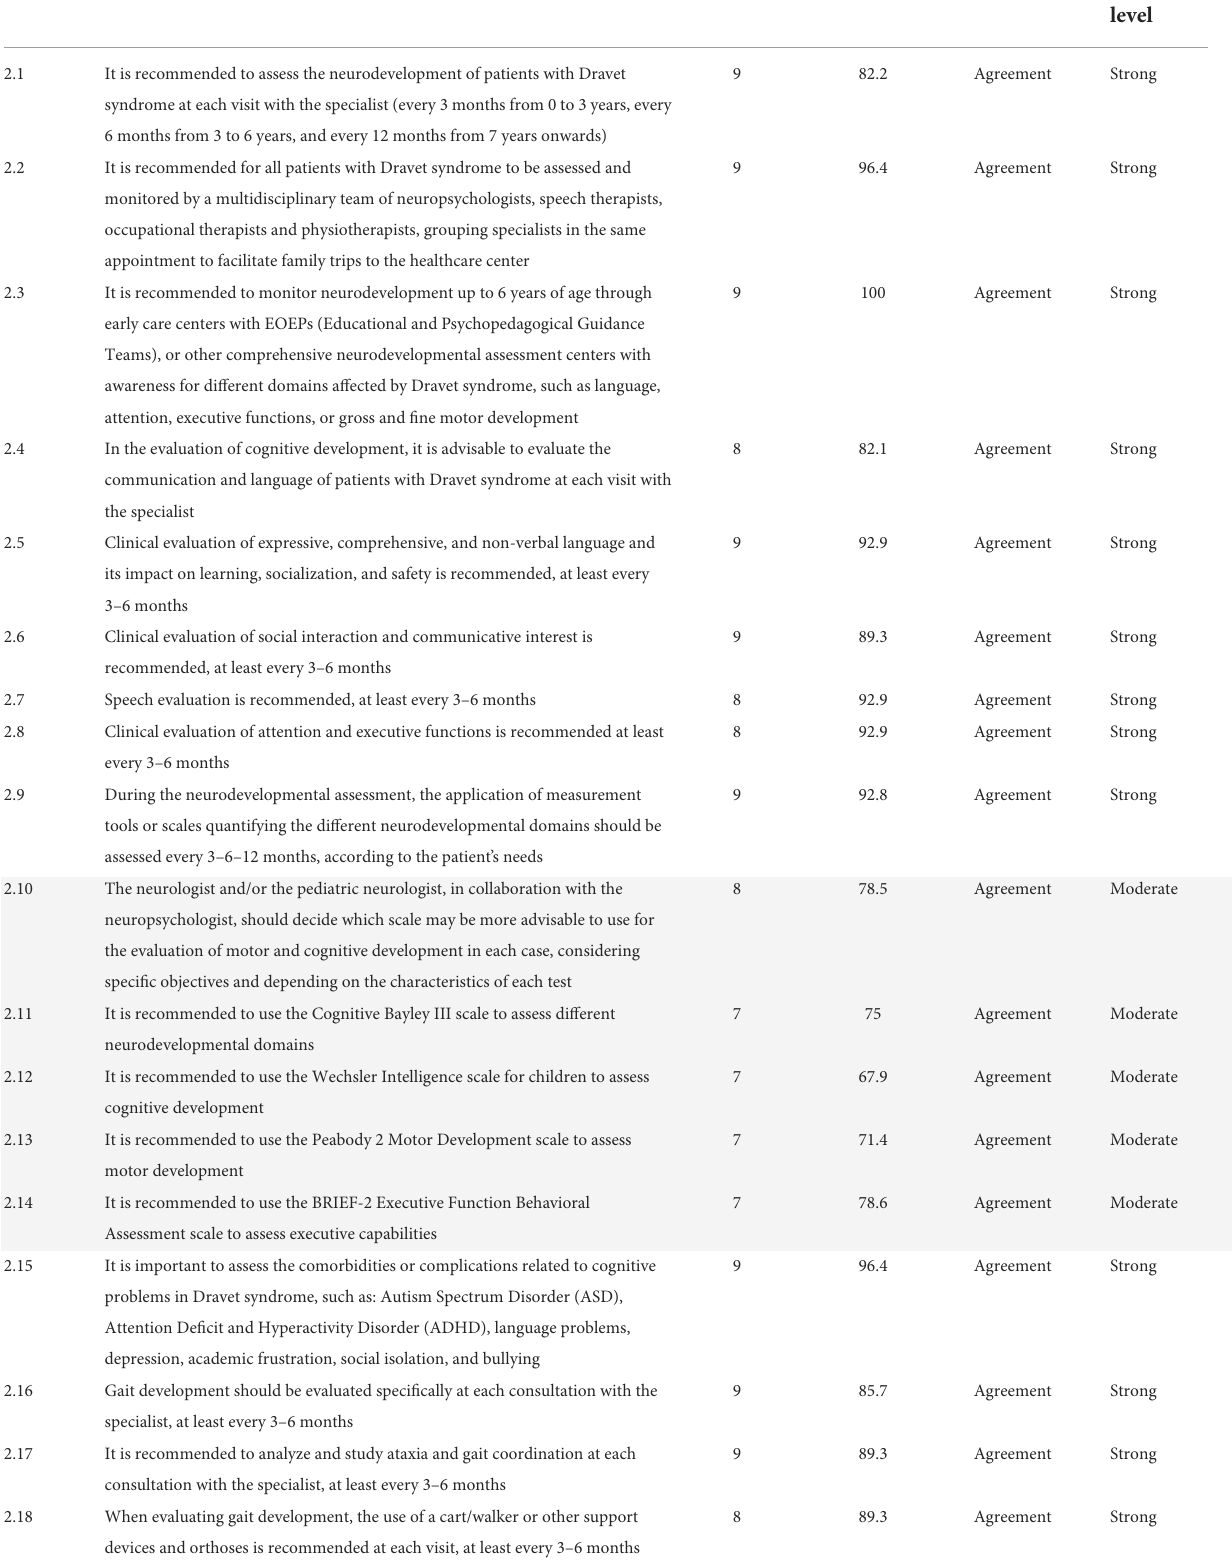
TABLE 2 Evaluation of neurodevelopment in patients with Dravet syndrome (block 2). Statement Median % Consensus Result